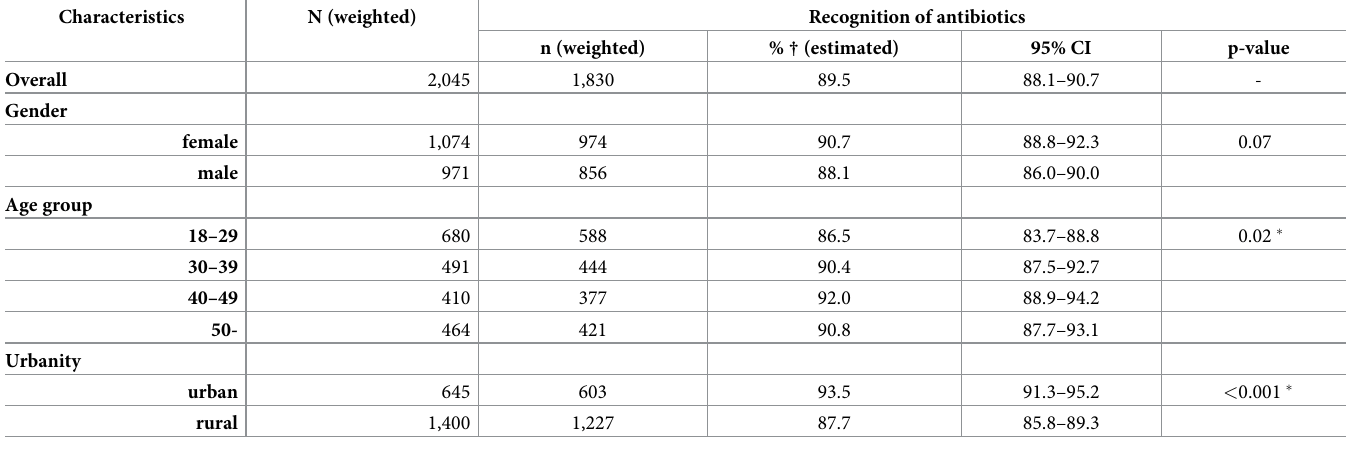
Table 2. Participants’ recognition of antibiotics (N =